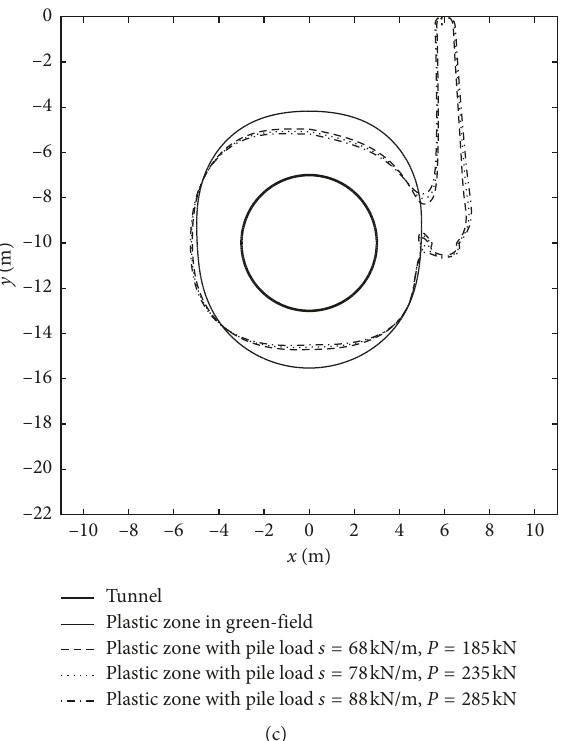
Figure 5: Envelopes of potential plastic zones for different conditions. (a) Three different offsets of pile from tunnel. (b) Three different pile lengths. (c) Three different magnitudes of pile loads.